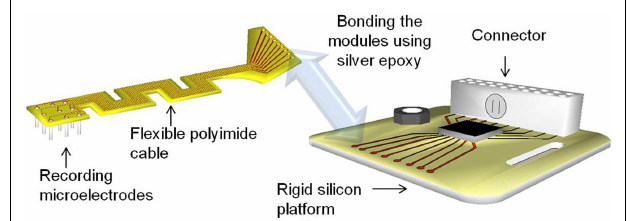
FIGURE 1 | Illustration of the modular electrode design . Image not drawn to scale.